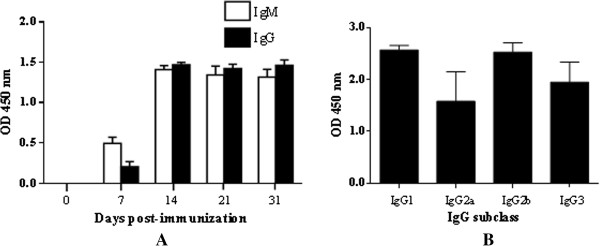
Immune responses in pkMSP-142-immunized mice. (A) IgM and IgG levels in pkMSP-142-immunized mice. Both IgM and IgG were detected at day 7 post-immunization and the levels increased throughout the whole immunization period. (B) IgG isotype-specific antibody levels. The IgG isotype distribution in pkMSP-142-immunized mice was IgG1 > IgG2b > IgG3 > IgG2a.